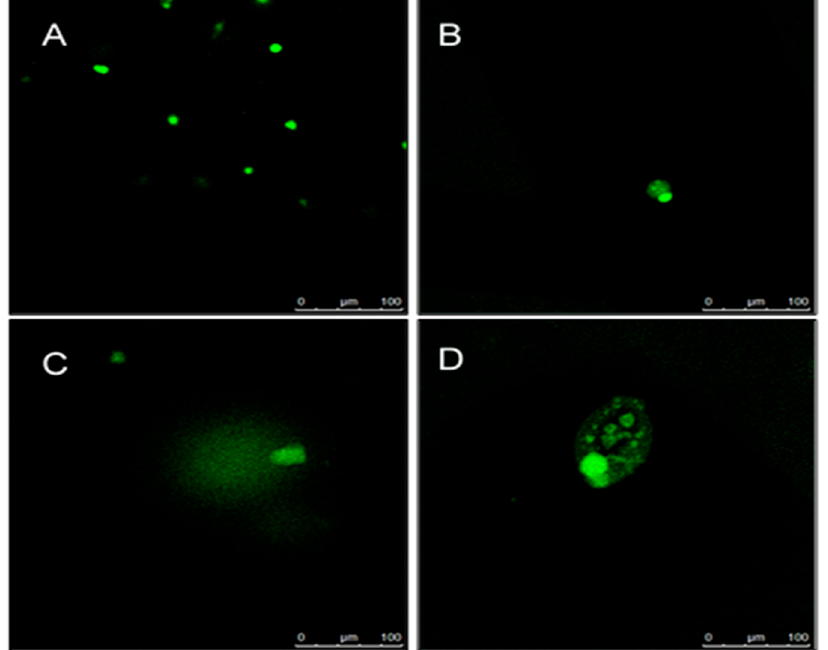
Figure 6. Evaluation of genotoxic effects induced by different concentrations of D. hispida aqueous extract. ( A ) control: nucleus without DNA damage ( B ) 250 mg/kg BW: mild DNA damage ( C ) 500 mg/kg BW: moderate DNA damage ( D ) 1000 mg/kg BW: nucleus with necrotic cell. The final data were presented as an olive tail moment (OTM).